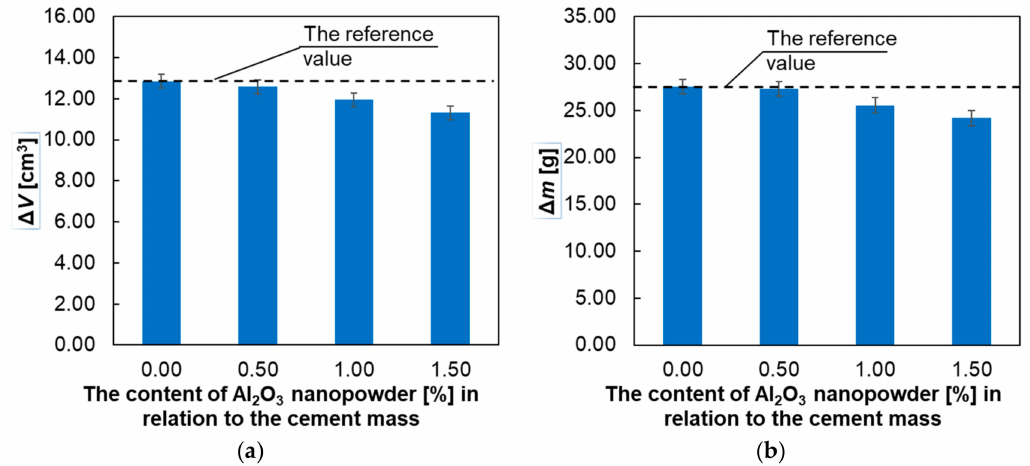
Figure 9. Test results of the abrasion resistance of the hardened mortars: ( a ) volume loss ∆ V ; ( b ) mass loss ∆ m.